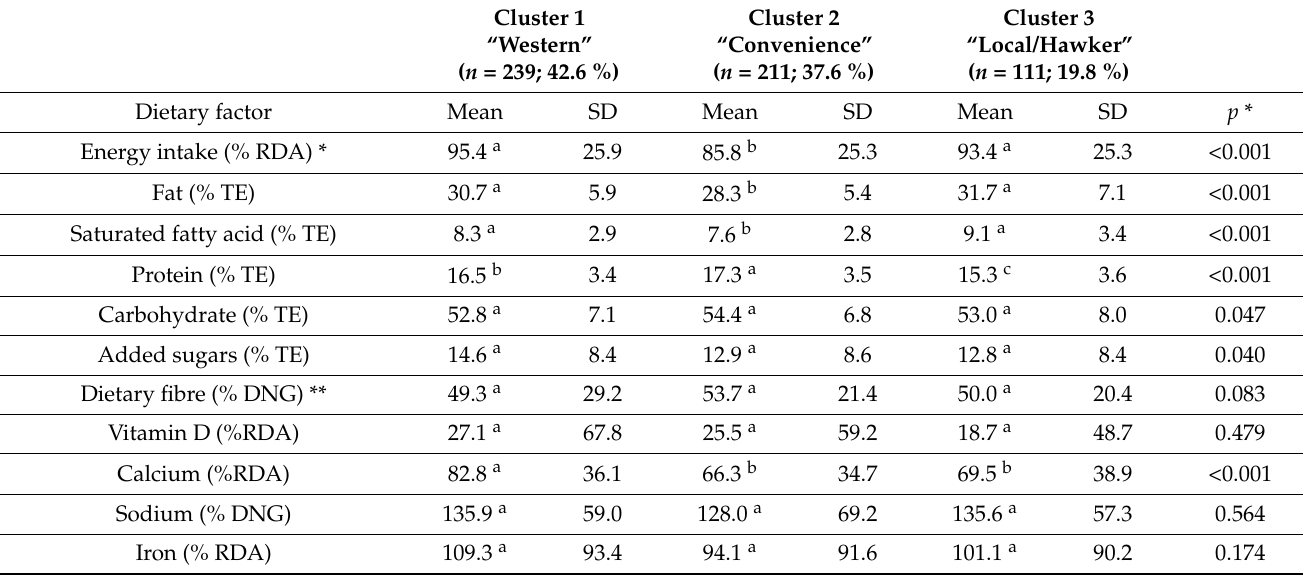
Table 2. Estimated intake of nutrients and energy in relation to local or international recommendations